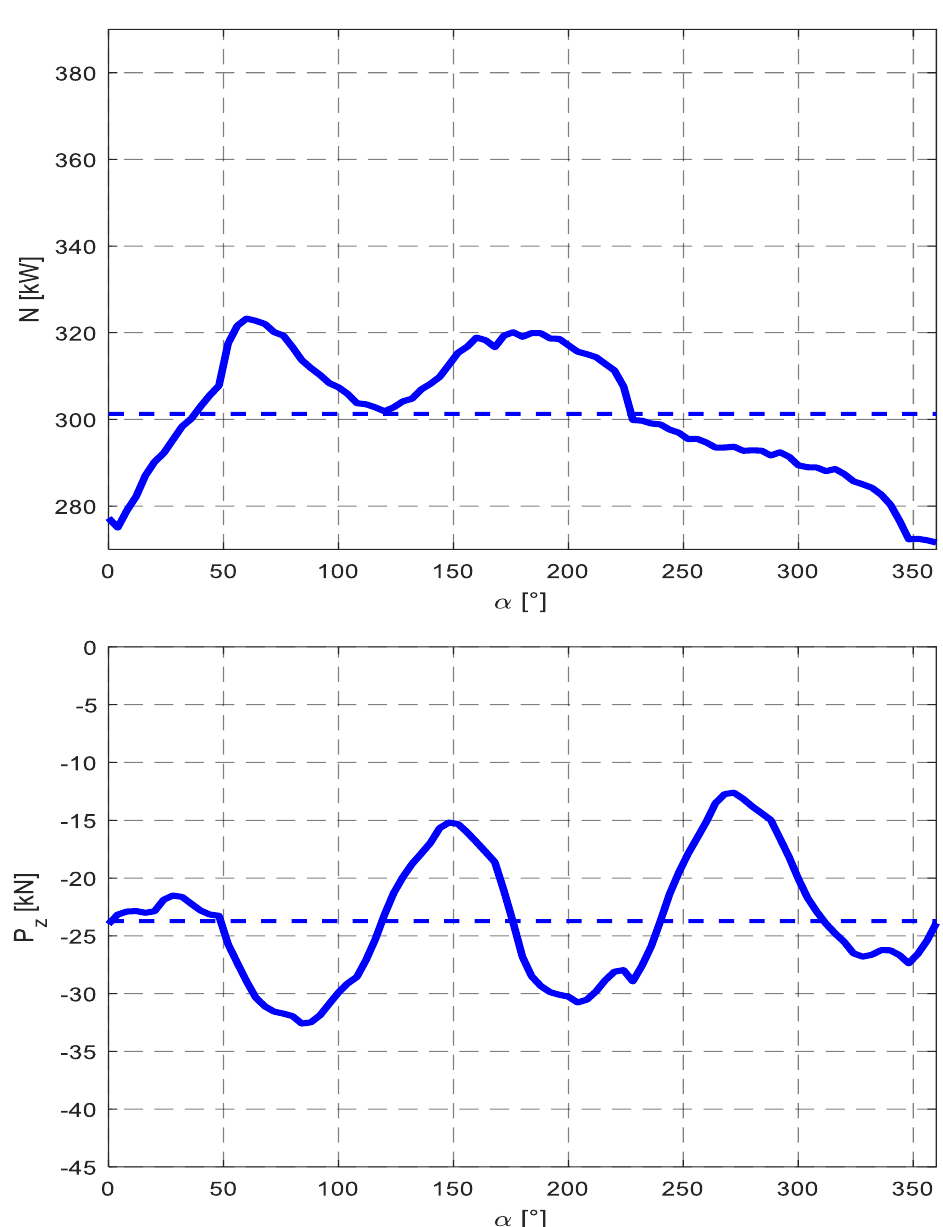
Figure 12. Waveform of the values of power N and cutting head impact force in the direction of shearer’s advance P z for pick arrangement 1.